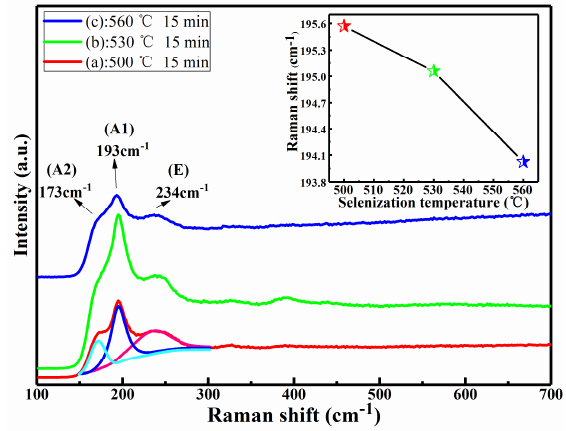
Figure 2. Raman spectra of the CMZTSSe films annealed at different temperatures. Inset: The main Raman peaks of A1 mode for CMZTSSe films annealed at different temperatures.